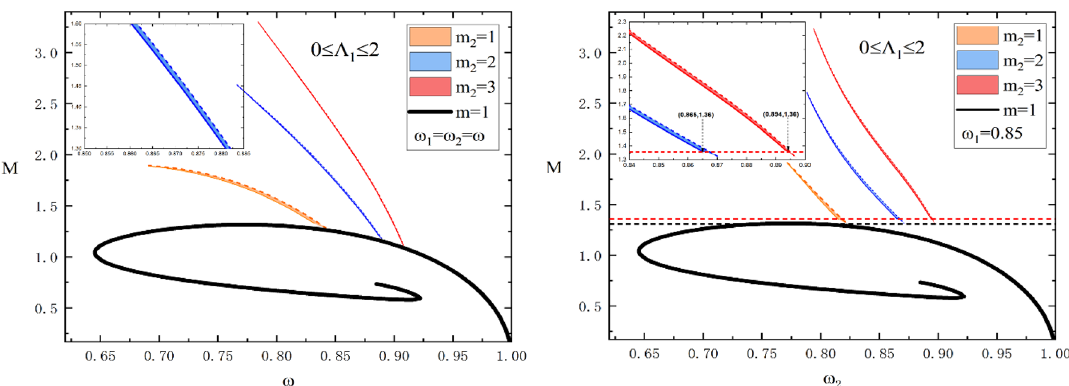
Figure 2 . Left : the mass M of the SIMBSs versus the synchronized frequency ω with the azimuthal harmonic indexes m 2 = 1 , 2 , 3 . Right : the mass M of the SIMBSs versus the nonsynchronized frequency ω 2 with ω 1 = 0 . 85 . The horizon red dashed line indicates the mass M = 1 . 36 , and the black dashed line indicates the mass M = 1 . 31 . In both panels, the dashed, solid lines denote Λ 1 = 0 and Λ 1 = 2 , respectively. The black spiral curve indicates the ground state with an azimuthal harmonic index m = 1 . All solutions have µ 1 = 1 , µ 2 = 0 . 93 , and m 1 = 1